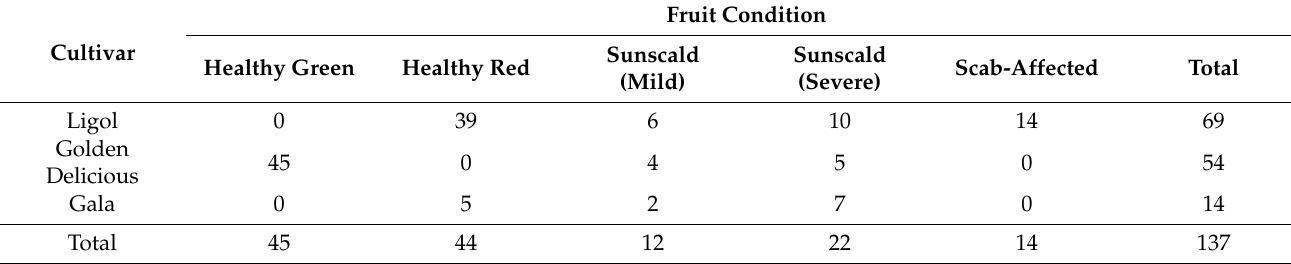
Table 2. The number of apple fruits studied in this work.